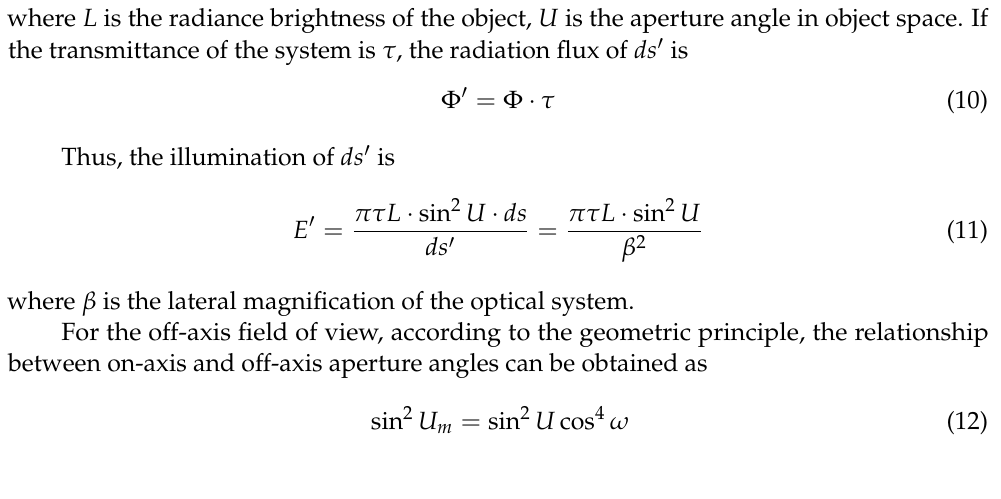
Table 2. Technical Specifications of the optical system.